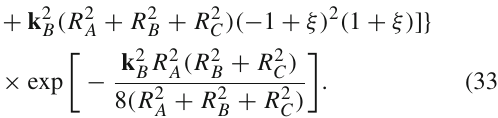
Fig. 6 The variation of partial decay widths of the D ∗ s ( 2715 ) mesons to a pairs of the D s ( 1968 ) and η mesons as a function of R D ∗ (GeV − 1 ) for two values of baryonic densities ( ρ 0 and 4 ρ 0 ), isospin